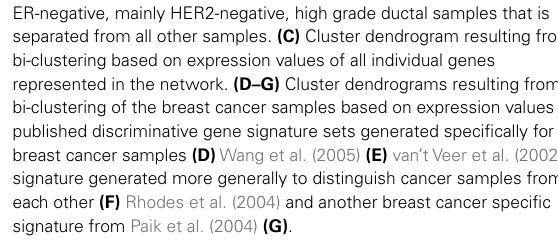
FIGURE 2 | Hierarchical clustering of a breast cancer sample set . (A) Heatmap representation of a complete linkage hierarchical bi-clustering of network module activity, based on expression data of 113 breast cancer samples of Lu et al. (2008) data set; the resulting dendrogram is annotated according to the clinical sample annotation using the color code as indicated in the legend; labelings are from top to down: labeling 4, tumor type; labeling 3, tumor grade; labeling 2, HER2 expression status; labeling 1, estrogen receptor (ER) expression status; regions analyzed in more detail in Figures 3A,B are indicated by black vertical bars. (B) Magnification of the dendrogram from (A) showing the cluster of mainly